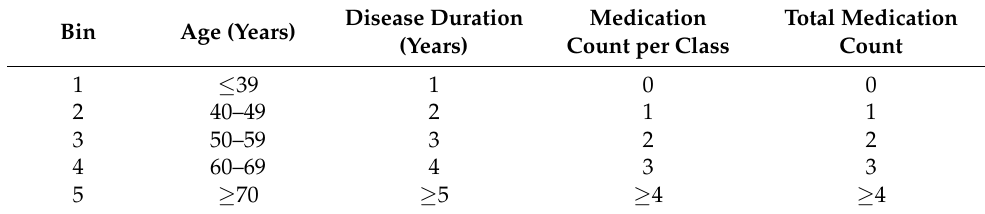
Table 6. Range of age values, disease duration, and medication counts for each bin.